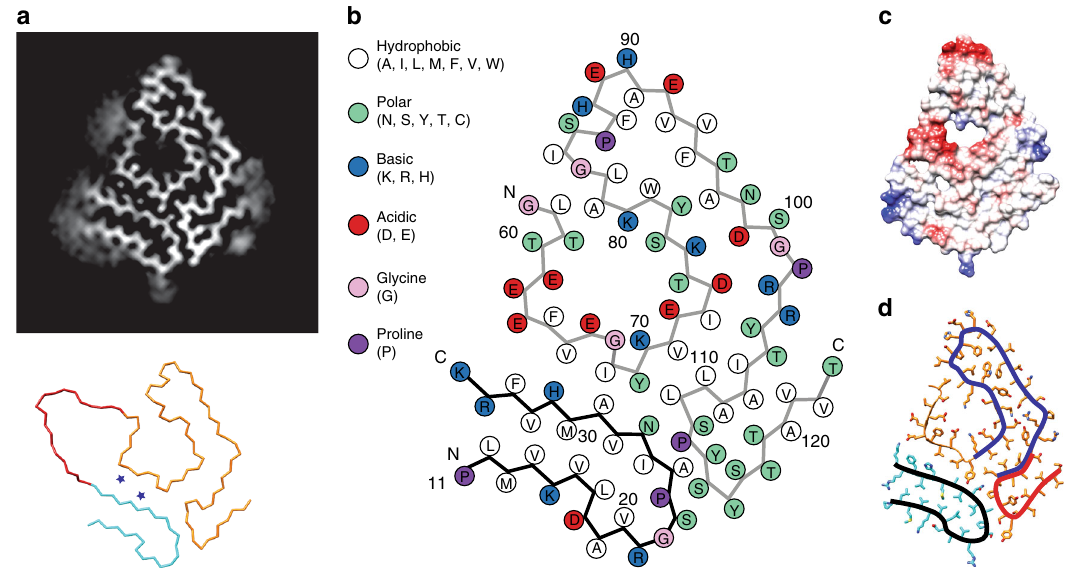
Fig. 2 Packing and overall fold of the fi bril protein. a Top: cross-sectional view of a 5-Å thick slice of the 3D map; bottom: C α -trace of TTR residues Pro11- Lys35 (cyan) and Gly57-Thr123 (orange). Residues Ala36-His56 are modelled in an arbitrary conformation, showing the ability of this segment to connect the N- and C-terminal segment. The blue asterisks indicate the position of two density features not captured by our model. b Packing scheme of one cross- sectional layer. c Electrostatic surface pro fi le of one molecular layer of the fi bril. d The fi bril protein contains arches at residues Pro11-Lys35 (black), Lys70-Leu111 (blue) and Thr106-Thr123 (red)